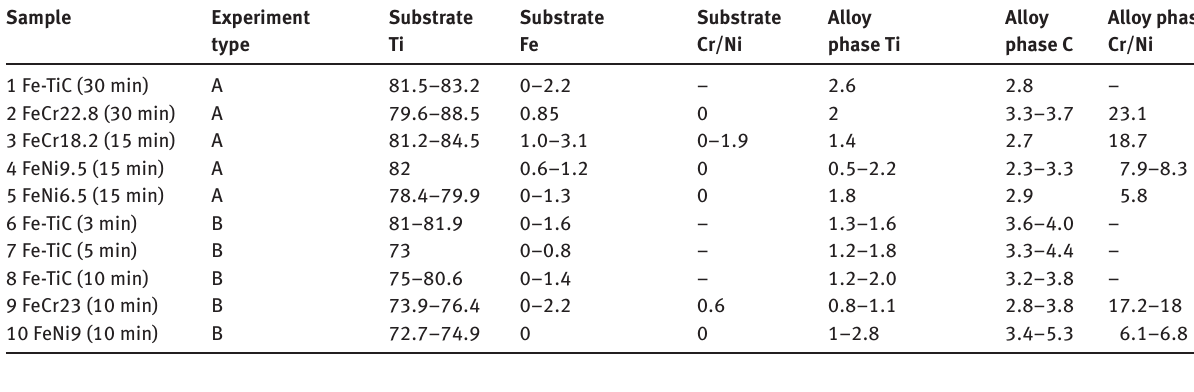
Table II: Average SEM-EDS analyses of the substrate and the alloy at the penetration zone (Results from experiments type A from [19]). (All values in mass%)